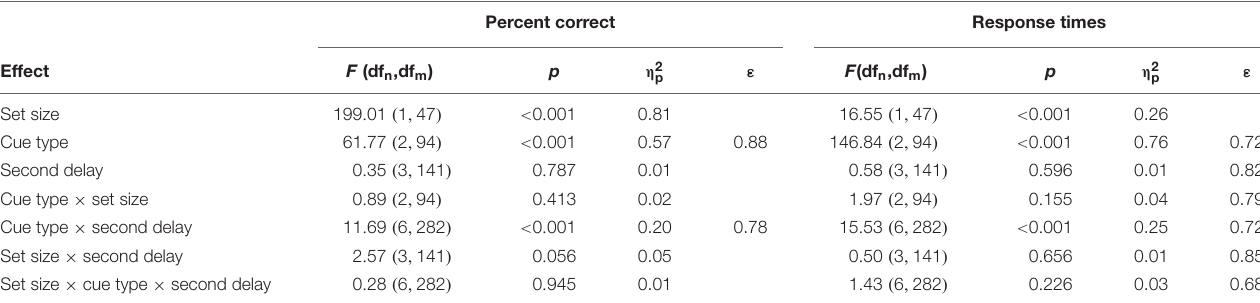
FIGURE 2 | Mean percent correct (PC; Left) and mean correct response times (RTs; Right) as a function of second delay and cue type. Error bars are 95% confidence intervals for each data point. TABLE 3 | Detailed test statistics for the three-way ANOVA on mean percent correct and response times as dependent measures (Analysis 1 in the main